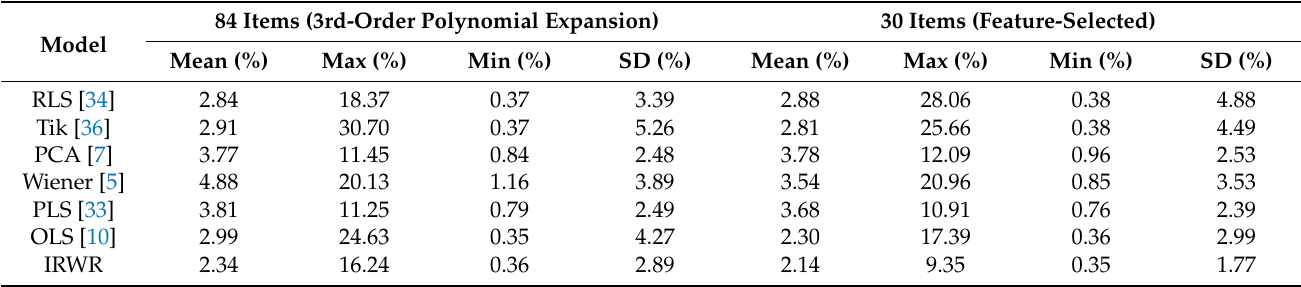
Table 3. The comparison of estimation accuracy in terms of RMS using ten-fold cross-validation. 84 Items (3rd-Order Polynomial Expansion) Model